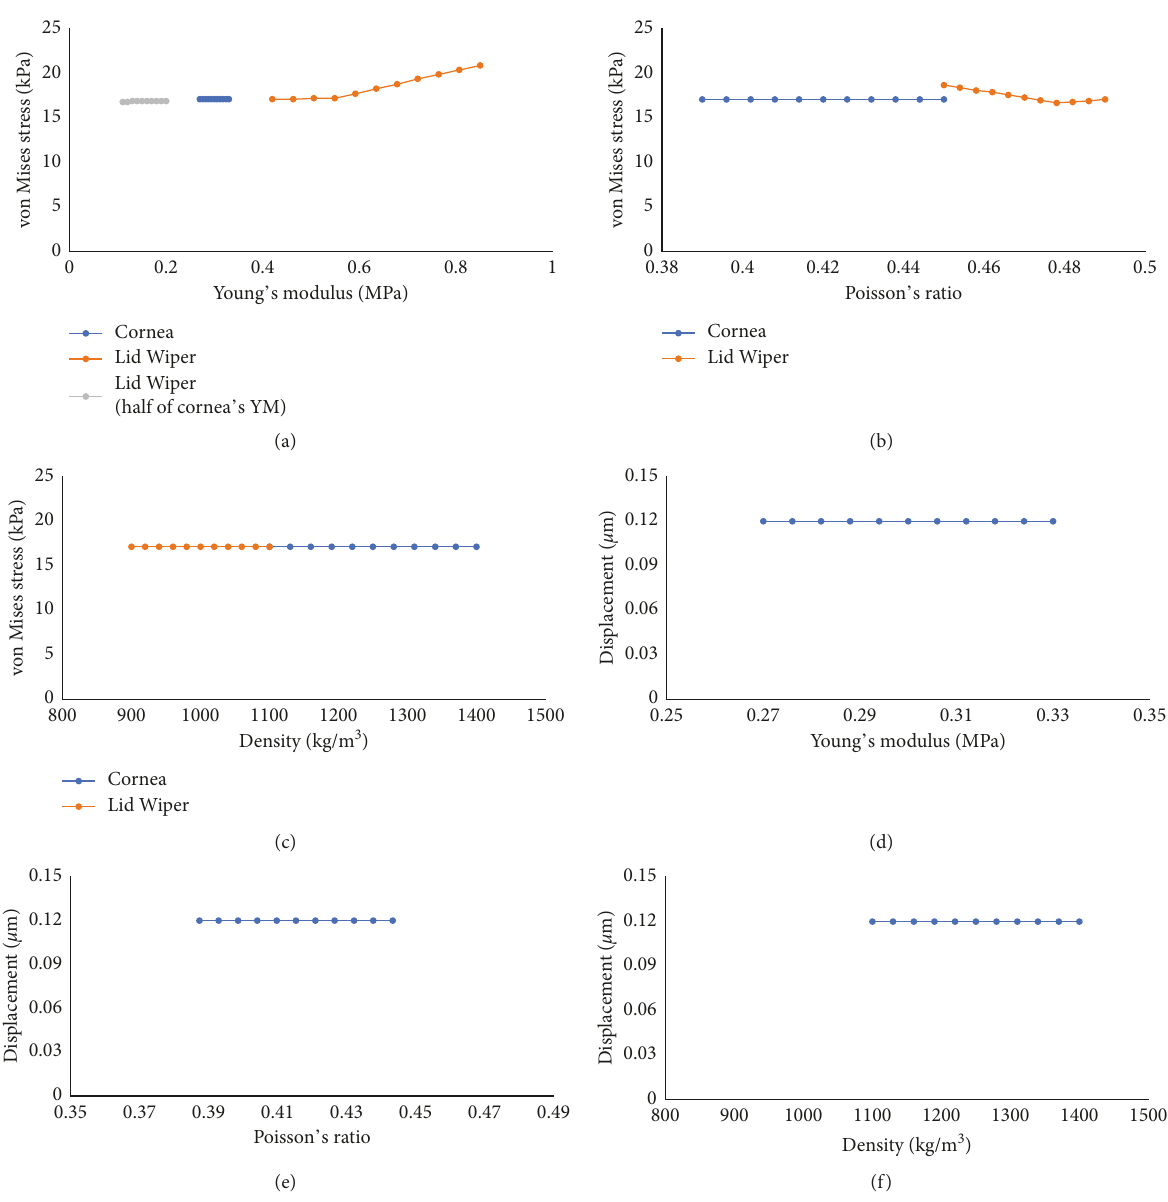
Figure 3: Sensitivity analysis of the material properties of the cornea and lid wiper. Change in Young’s modulus of cornea does not have any effect on the VMS of the cornea whereas VMS increases slightly with the increase in Young’s modulus of the lid wiper (a). Change in Poisson’s ratio of cornea does not have any effect on the VMS of the cornea whereas VMS decreases slightly with the increase in Poisson’s ratio of the lid wiper (b). Change in density does not have any effect on VMS of the cornea and lid wiper (c). Change in Young’s modulus, Poisson’s ratio, and density does not have any effect on displacement of the cornea (d–f). Graph drawn with Microsoft Excel 2019